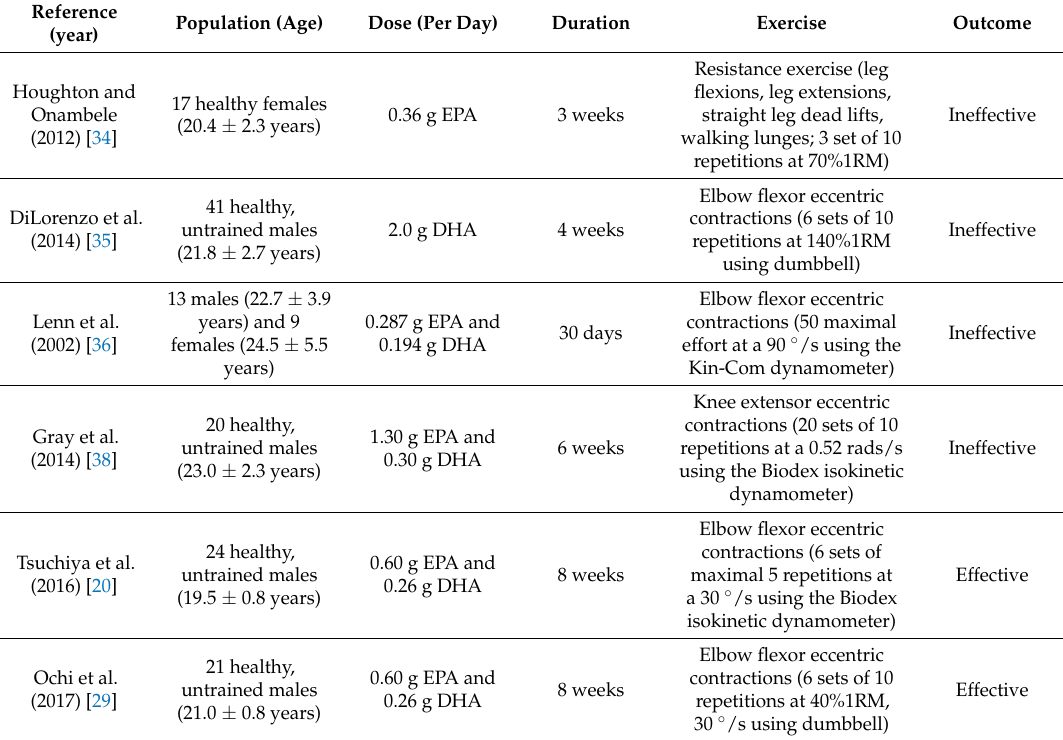
Table 1. Summary of the effects of EPA/DHA supplementation on muscle strength